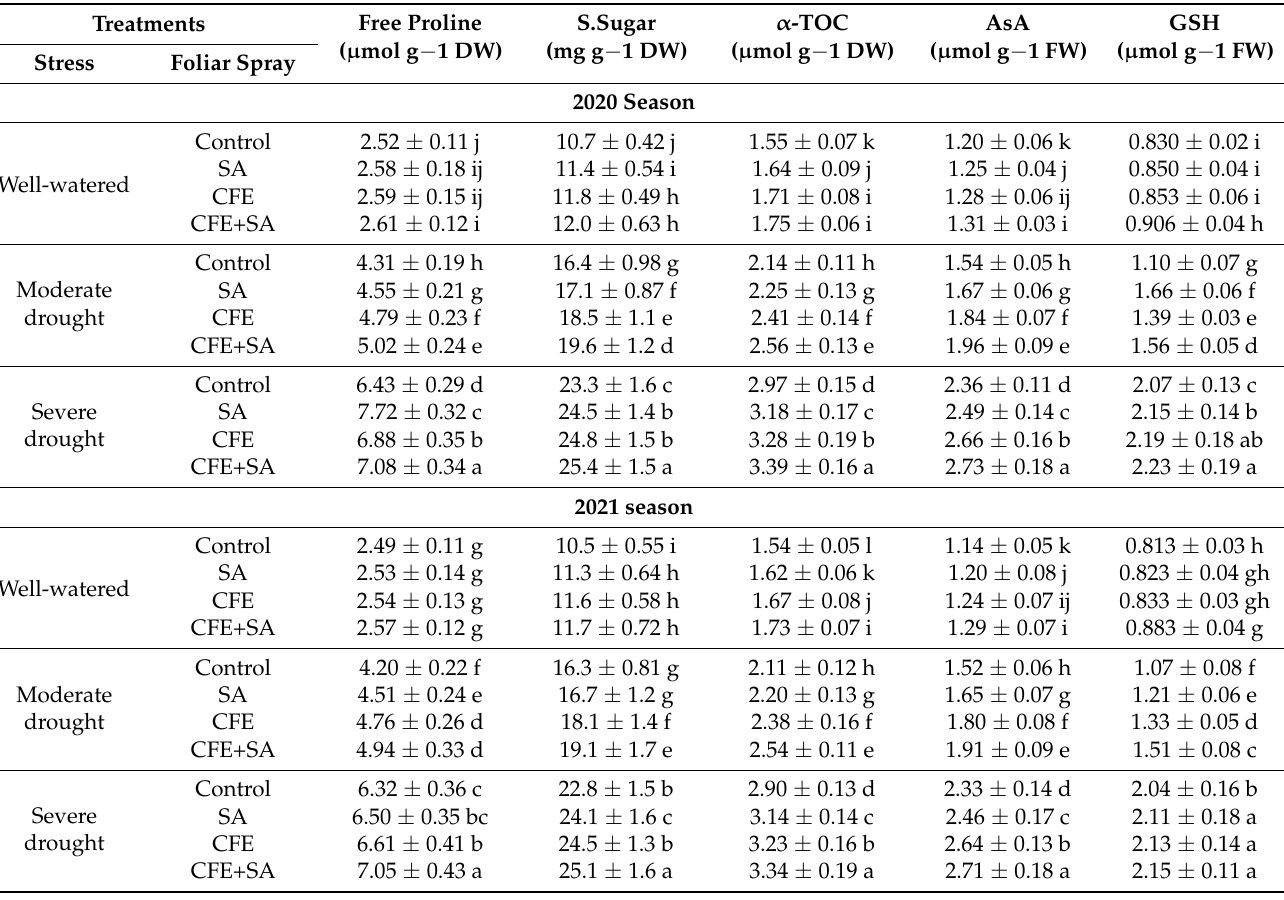
Table 6. Influence of foliar nourishment with clove fruit extract (CFE) and salicylic acid (SA) on free proline, soluble sugars (S.sugar), α -tocopherol ( α -TOC), ascorbic acid (AsA), and glutathione (GSH) contents of potato plants grown under three irrigation regimes in two seasons.